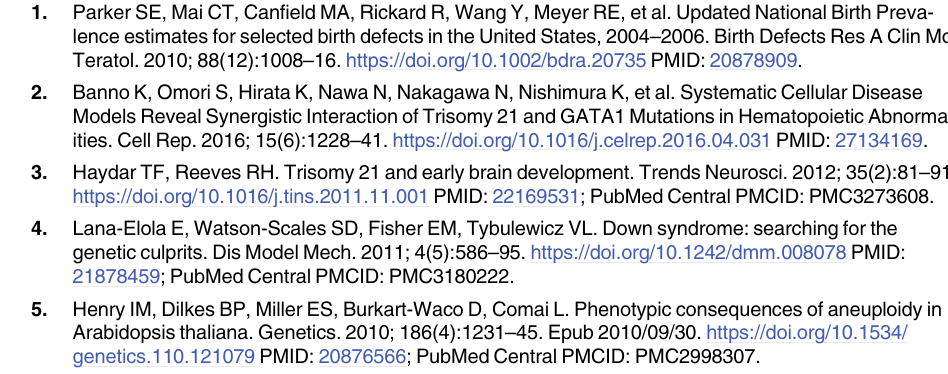
S5 Fig. SA- β -gal expression in iPSCs. Percentages of SA- β -gal positive cells were calculated for undifferentiated iPSC lines (n = 4 per cell line). cDi21, corrected disomy 21 iPSCs; Tri21, trisomy21 iPSCs; N.S., not significant. (TIF) S1 Table. Characteristics of samples in the present study. Information on sex and age at sample collection for each patient is